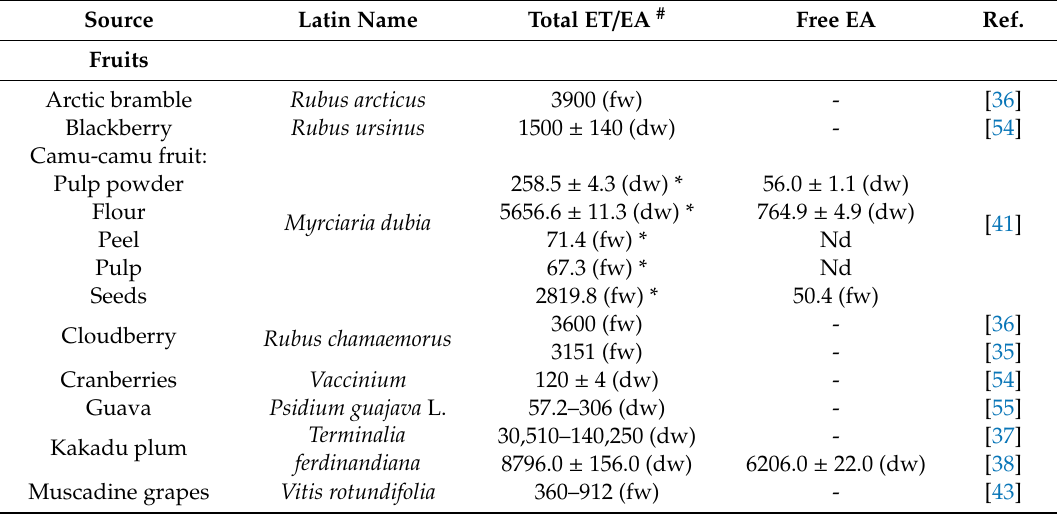
Table 1. Sources of EA and its content (mg · kg − 1 ) in di ff erent fruits, nuts, seeds and woods